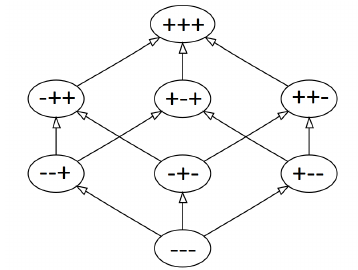
Figure 4. The graph G d for d = 3 representing the spatial location of the 8 octants of R 3